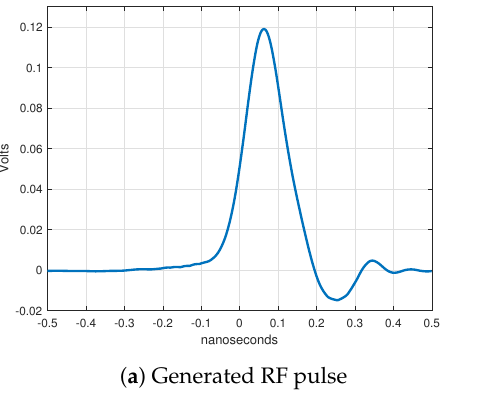
Figure 10. Measured results of sampler.